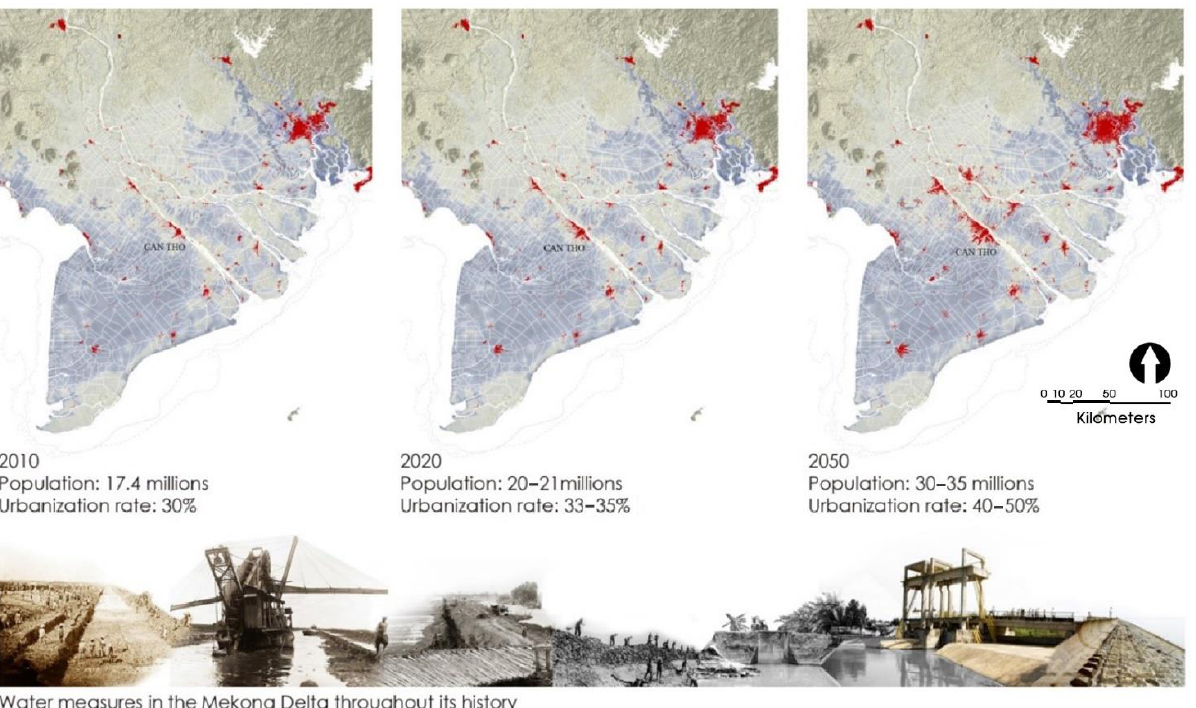
Figure 5. Rapid urbanization of territories and water control policies turn the cities away from water. Given the wet nature of the floodplain, the VMD needs to have a new awareness of a hydraulic city in response to environmental challenges in order to better adapt. Source: Reproduced from source [52].